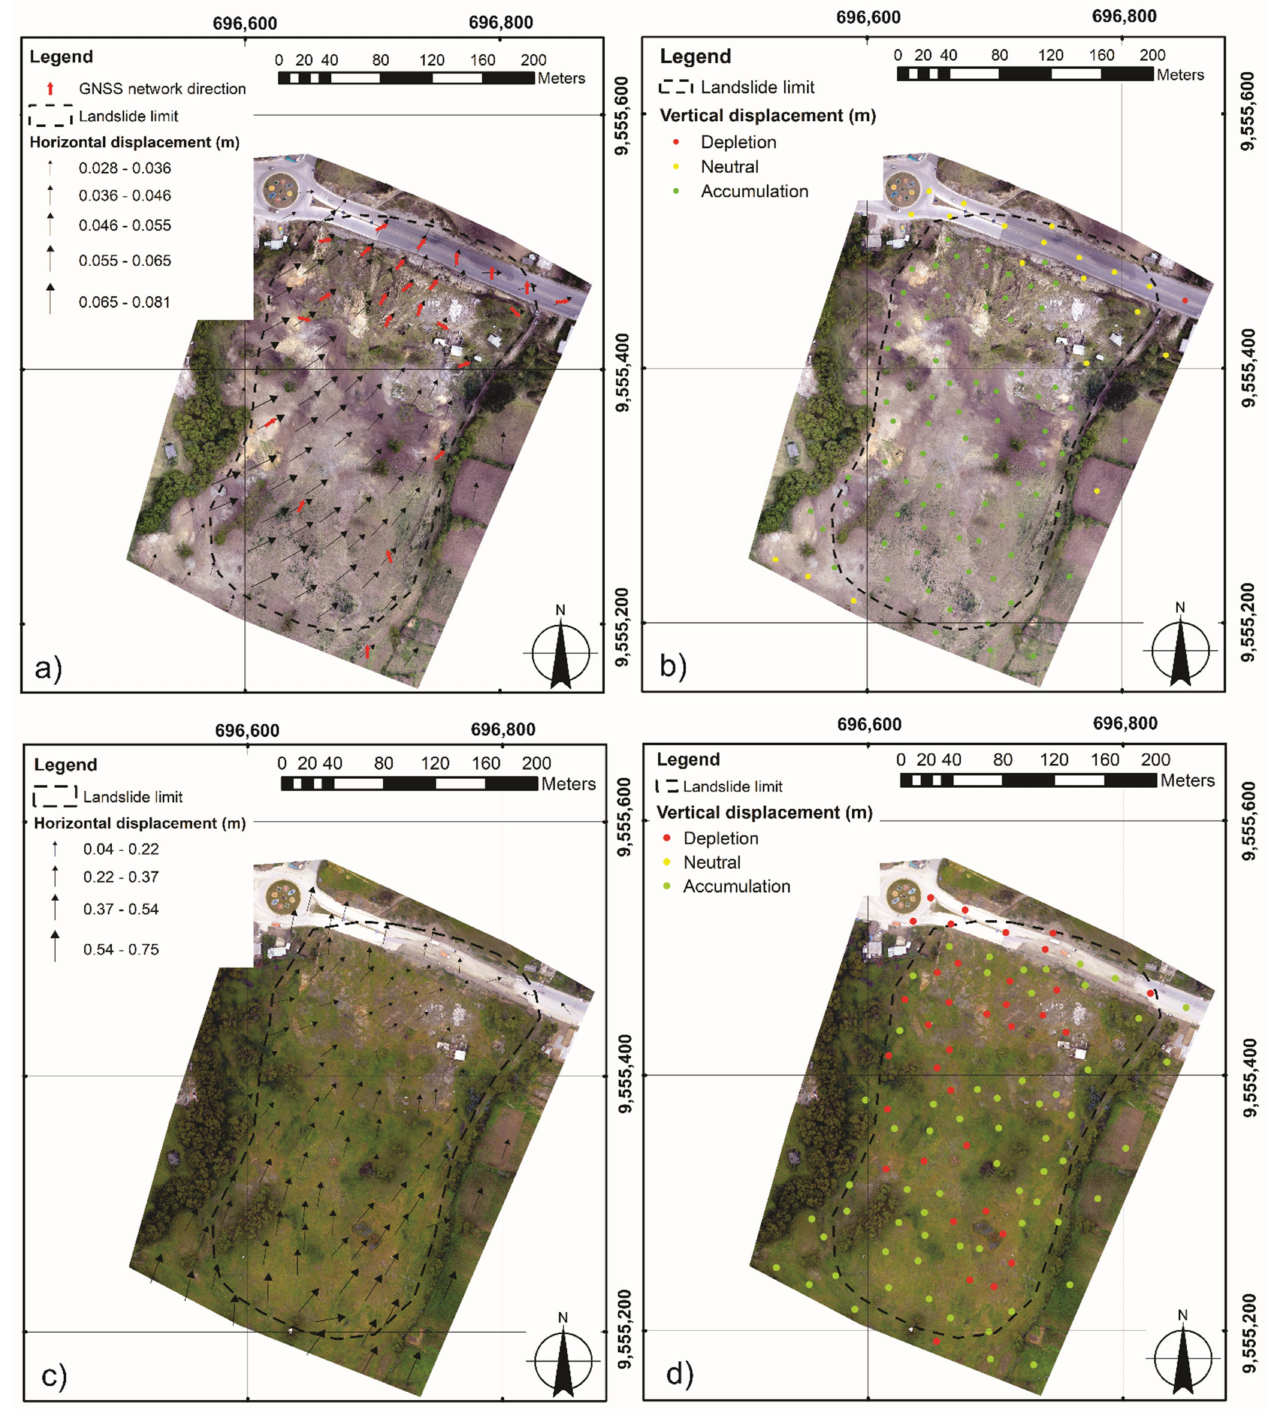
Figure 8. Map of direction and velocity vectors of the landslide area of the Colinas Lojanas study area: ( a , b ) correspond to the period from 4 July 2016 to 29 November 2016. GNSS network direction has been added; ( c , d ) correspond to the period from 29 November 2016 to 12 January 2018 (no data GNSS in this